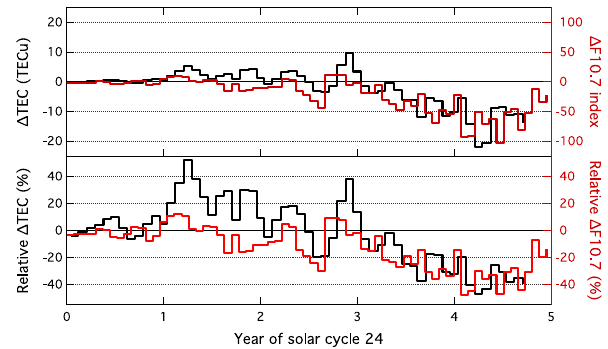
Figure 8. Absolute (upper) and relative (lower) changes in monthly mean TEC (left axis) and the 27-day mean F10.7 index (right axis) between SC24 and SC23. The number labels on the x axis denote the year counted from the beginning of